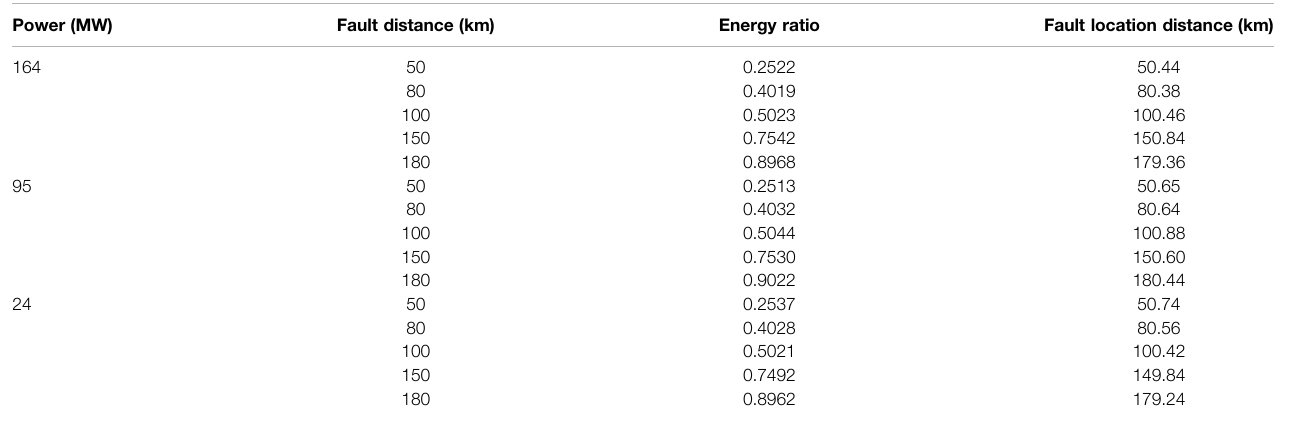
TABLE 2 | Single-pole abnormal grounding distance